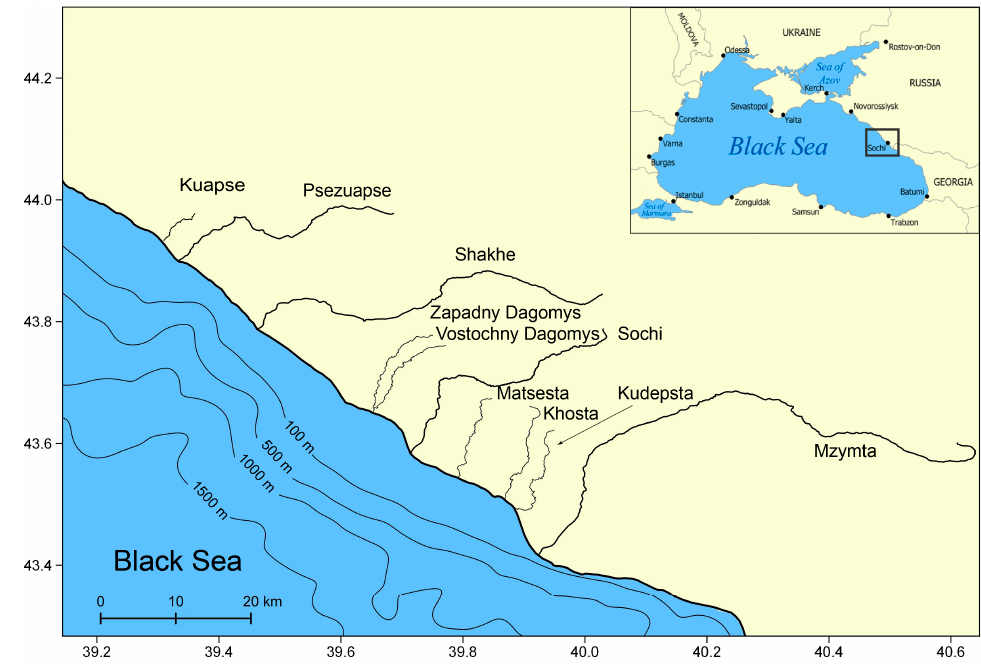
Figure 1. Study area, bathymetry, and locations of the rivers addressed in this study. The black box at the inset shows the location of the study area in the northeastern part of the Black Sea.